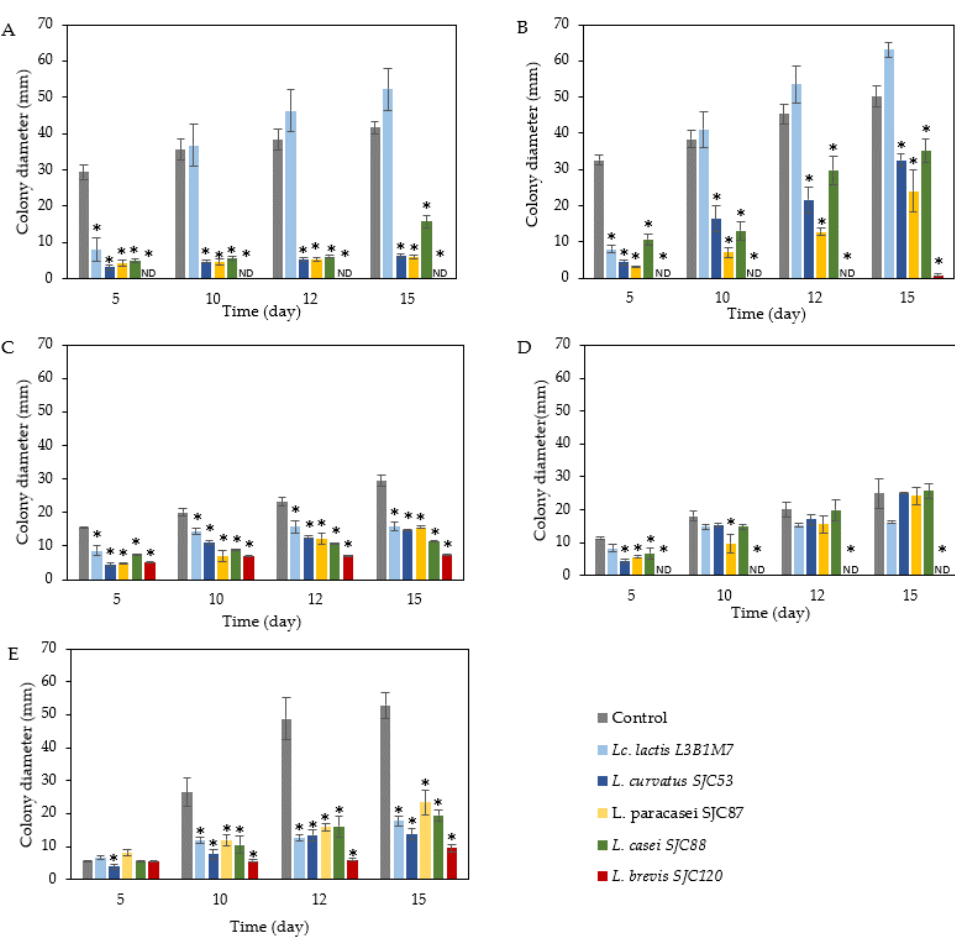
Figure 2. Effect of whey – gelatin films incorporated L. lactis L3B1M7, L. curvatus SJC53, L. paracasei SJC87, L. casei SJC88, and L. brevis SJC120 on fungal growth (mm) of ( A ) A. chevalieri , ( B ) A. flavus , ( C ) P. brevicompactum , ( D ) P. commune , and ( E ) P. nordicum for 15 days at 20 °C. Values are the mean ± SEM ( n = 3). * p < 0.05 versus control. ND: not detected (no fungal growth observed).